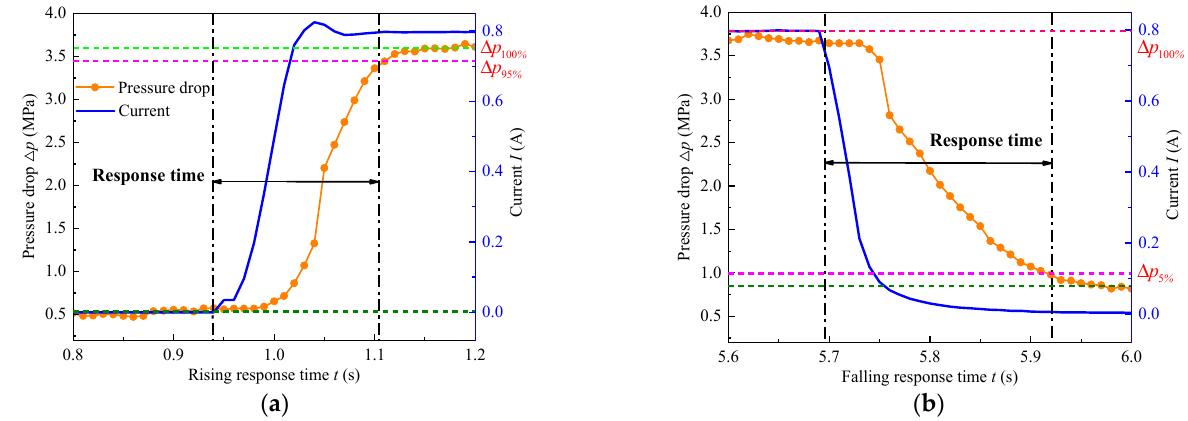
Figure 19. Definition of dynamic response time: ( a ) rising response time, ( b ) falling response time.